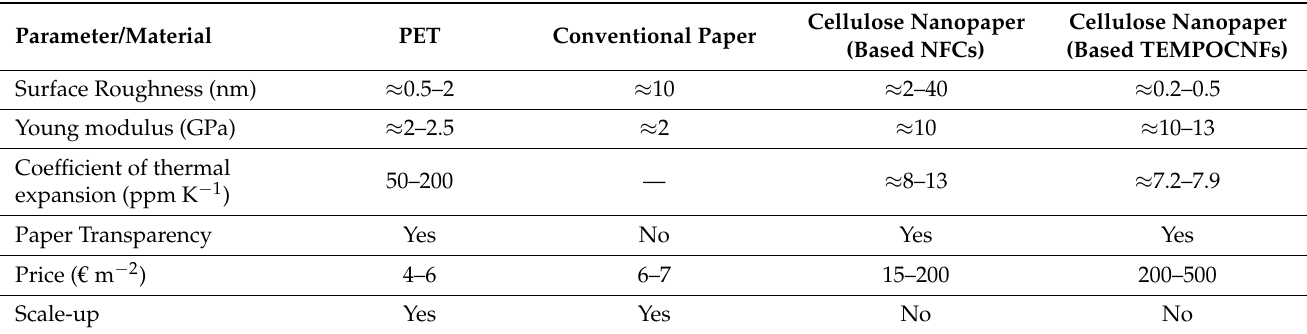
Table 3. Comparison of properties and cost for classical printed electronics substrates (plastic and conventional paper) and cellulose